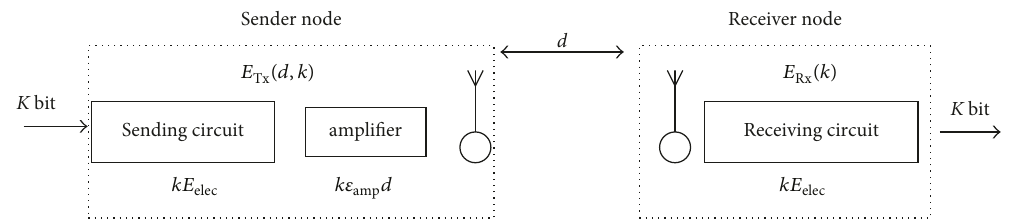
Figure 2: Energy consumption model of wireless sensor nodes in coal mine robot.